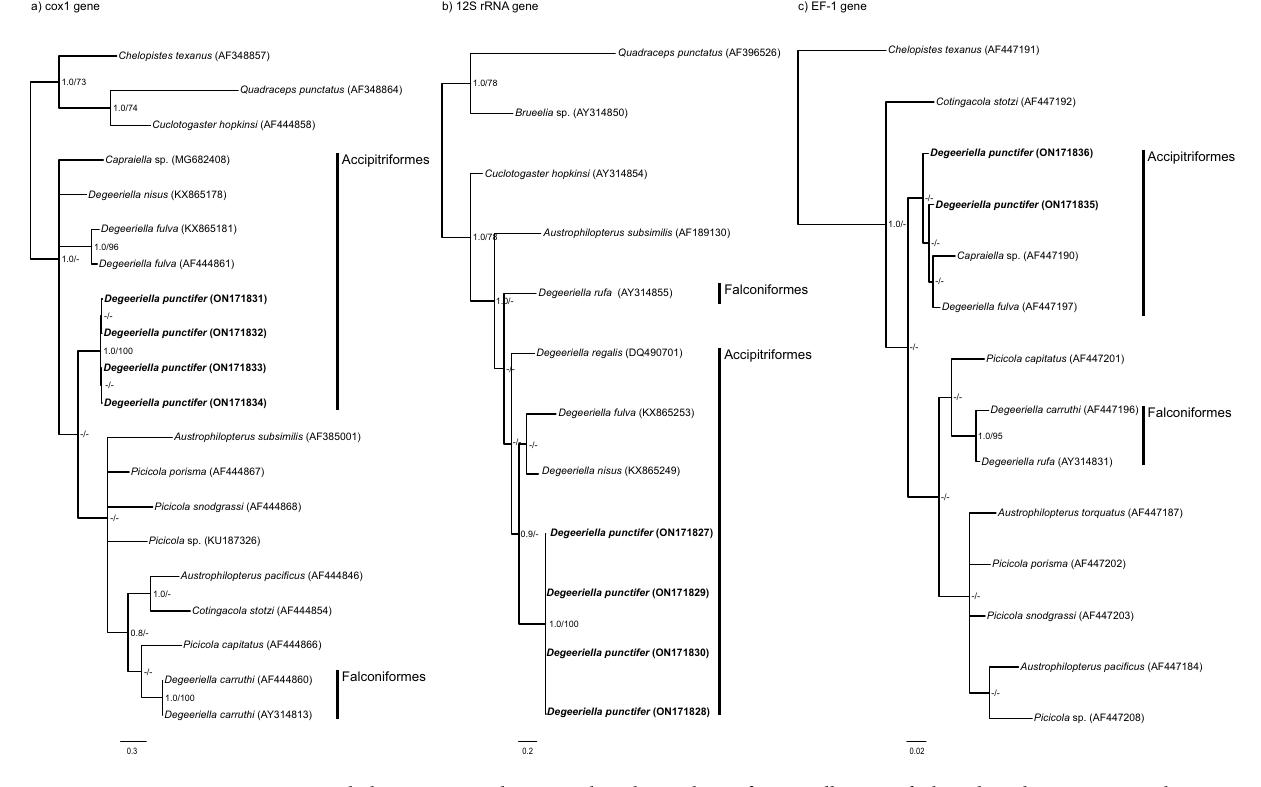
Figure 4. Phylogenetic tree depicting the relationships of Degeriella punctifer based on the Bayesian analysis of the ( a ) cox1 , ( b ) 12S rRNA and ( c ) EF1 genes analysed independently, and constructed using MrBayes v3.2.2 under the GTR+I+G model of nucleotide evolution for each gene. Posterior probabilities and maximum likelihood bootstrap support values (100 replicates) are given for each node. Posterior probabilities < 0.8 and bootstrap support values < 70% are not shown. The scale bars indicate the number of substitutions per site. The host order is given for Degeeriella species occurring in Falconiformes and